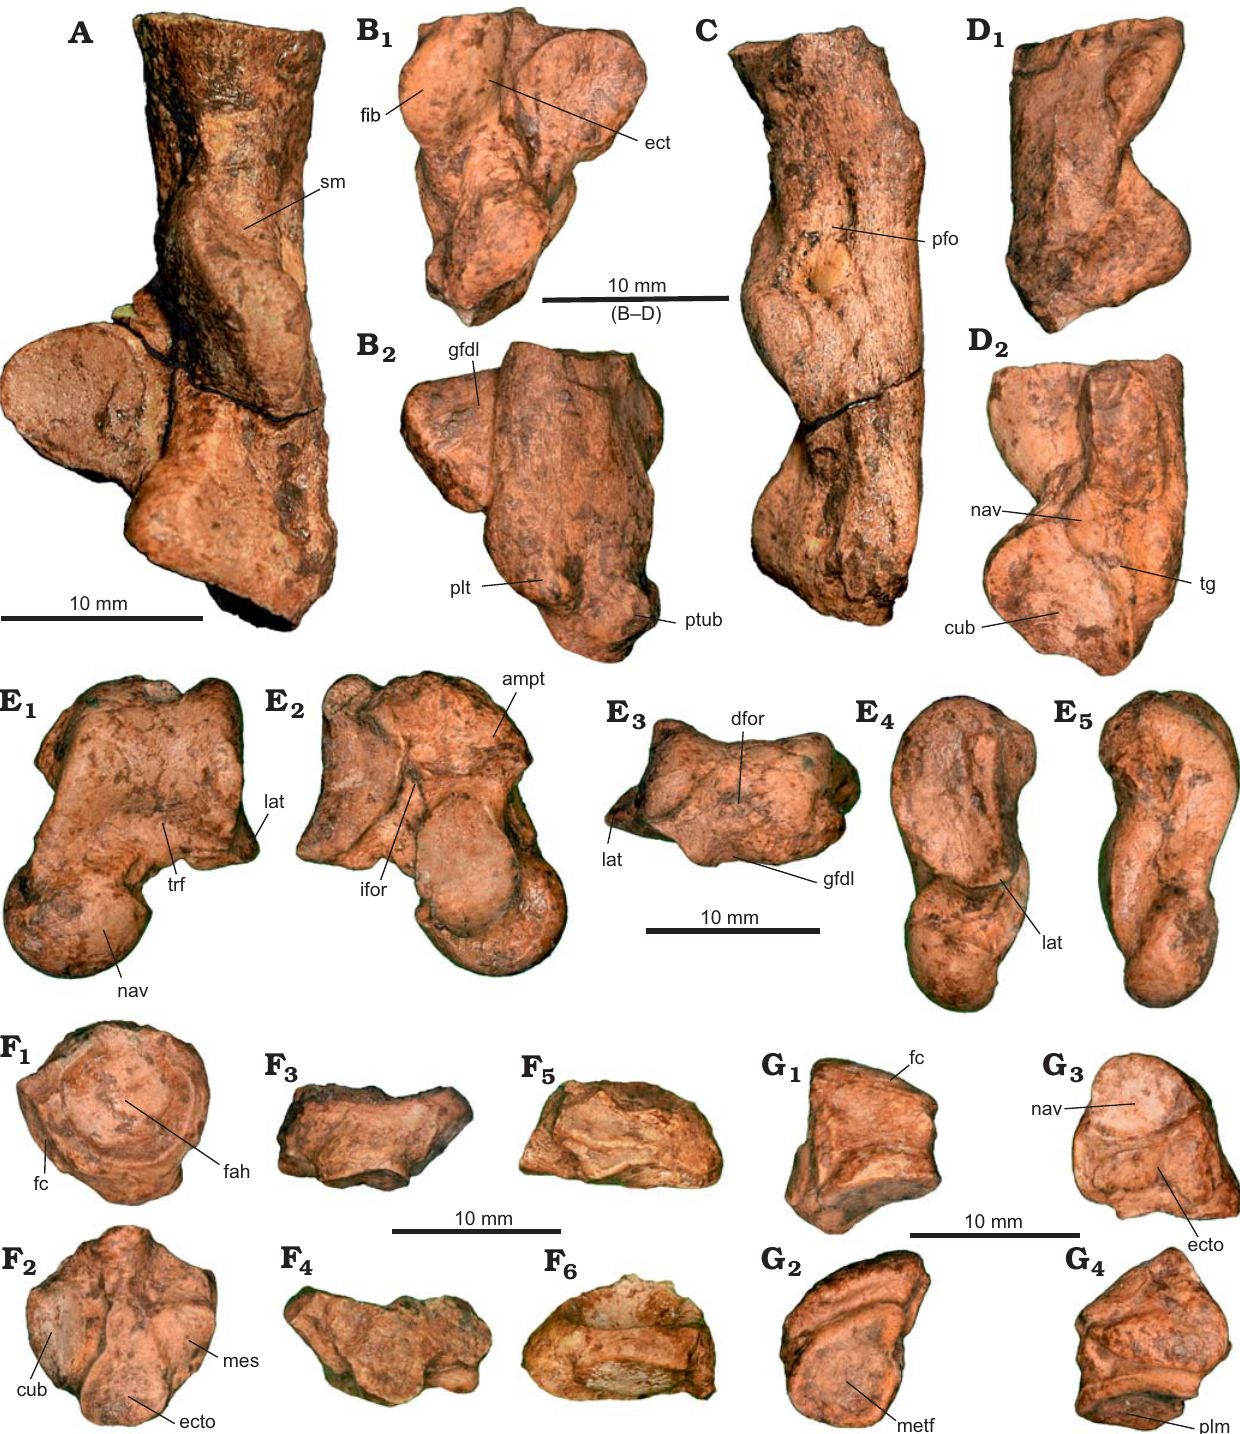
Fig. 5. Tarsal bones of typotherian notoungulate “ Campanorco inauguralis ” Bond, Vucetich, and Pascual, 1984 (IBIGEO-P 105) from El Simbolar, Salta Province, Argentina, Upper Lumbrera Formation, late middle Eocene (Barrancan subage of the Casamayoran SALMA). A . Left calcaneum in dorsal view. B . Right calcaneum in dorsal (B 1 ) and plantar (B 2 ) views. C . Left calcaneum in lateral view. D . Right calcaneum in lateral (D 1 ) and medial (D 2 ) views. E . Left astragalus in dorsal (E 1 ), plantar (E 2 ), posterior (E 3 ), lateral (E 4 ), and medial (E 5 ) views. F . Left navicular in posterior (F 1 ), anterior (F 2 ), dorsal (F 3 ), plantar (F 4 ), medial (F 5 ), and lateral (F 6 ) views. G . Left cuboid in dorsal (G 1 ), plantar (G 2 ), medial (G 3 ), and posterior (G 4 ) views. Abbreviations: ampt, astragalar medial plantar tuberosity; cub, cuboidal facet; dfor, dorsal astragalar foramen; ect, ectal facet; ecto, ectocuneiform facet; fah, facet for the astragalar head; fc, facet for the calcaneum; fib, fibular facet; gfhl, groove for the tendon of the flexor hallucis longus muscle; ifor, inferior astragalar foramen; lat, lateral process; mec, mesocuneiform facet; metf, metatarsal facet; nav, navicular facet; pfo, peroneal fossa; plm, tendon of the peroneous longus muscle; sm, small concavity; tg, tendinous groove; trf, fossa